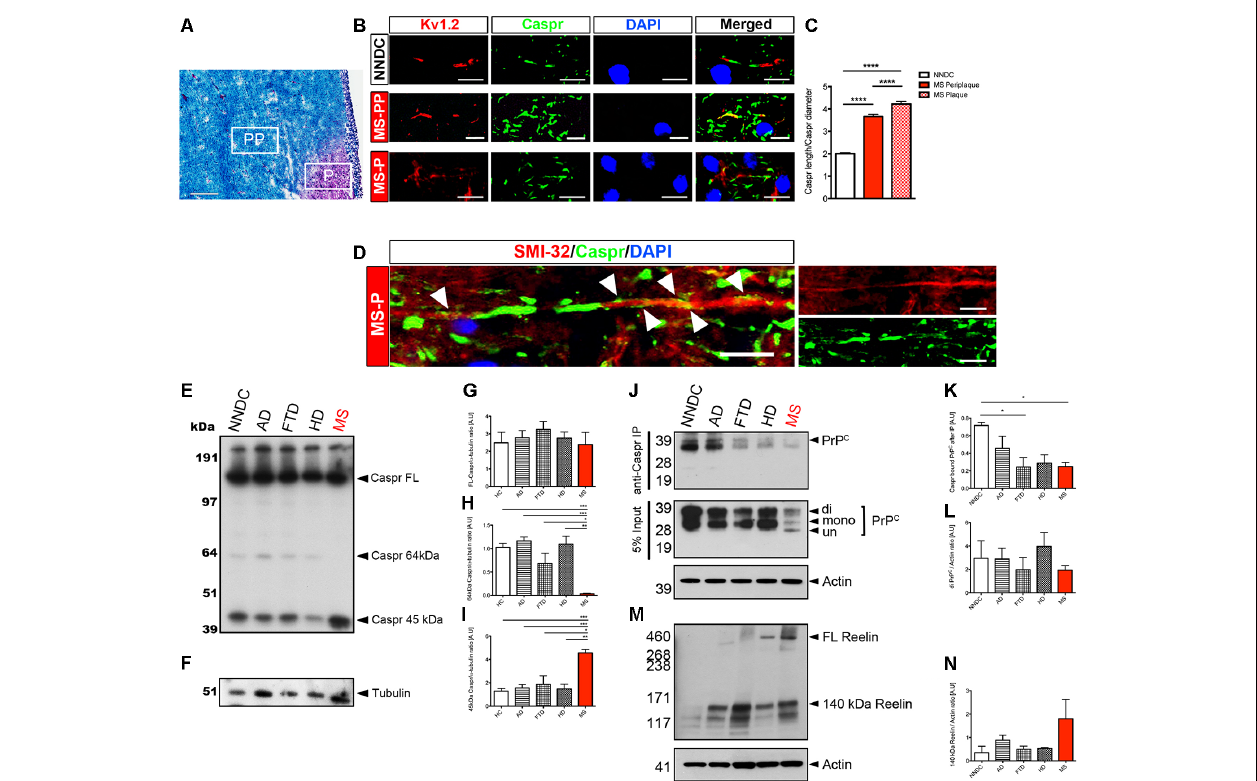
FIGURE 5 | Chronic active MS lesions show Caspr re-distribution, increased NgR1 and axonal damage. For detailed methods please see the Supplementary Information . (A) Representative LFB-PAS stained images obtained from progressive MS patient brain tissues. From these, we selected periplaque (PP) and plaque (P) regions to further study Caspr distribution in these areas (scale bar = 500 µ m). (B) In MS-PP, the co-localization of Caspr with juxtaparanodal Kv1.2 was observed. In MS-P, a significant elongation of Caspr+ segments and disrupted localization of Kv1.2 was observed (scale bar = 10 µ m). (C) The ratio between the measured length of Caspr+ segments vs. their diameter was significantly increased in MS-PP and MS-P, compared with non-neurological disease control (NNDC) samples. (D) Immunostaining of SMI-32, Caspr, and DAPI in serial section showed a re-distribution of Caspr along the whole internode in SMI-32 (+) degenerative axons within the lesion border (white arrowheads indicate diffuse expression of Caspr along the internode; scale bar = 10 µ m; one-way ANOVA with post hoc Tukey’s test, **** P < 0.0001, n = 4 for each patient samples). (E) Western blot for Caspr and (F) α -tubulin-loading control performed on brain white matter lysates of NNDC, Alzheimer’s disease (AD), frontotemporal dementia (FTD), Huntington’s disease (HD), and MS patients. (G) Densitometric quantification of full-length Caspr (FL-Caspr), (H) 64kDa degradation product of Caspr and (I) 45 kDa Caspr degradation product normalized by α -tubulin loading control (one-way ANOVA post hoc Tukey’s test, * P < 0.05, ** P < 0.01, *** P < 0.001, n = 4 for each patient samples). (J) Immunoprecipitation of Caspr and probed with anti-PrP C . Western immunoblot for PrP C from 5% input of pre-immunoprecipitation sample shown on the bottom (K) Densitometric quantification of Caspr bound PrP C and (L)